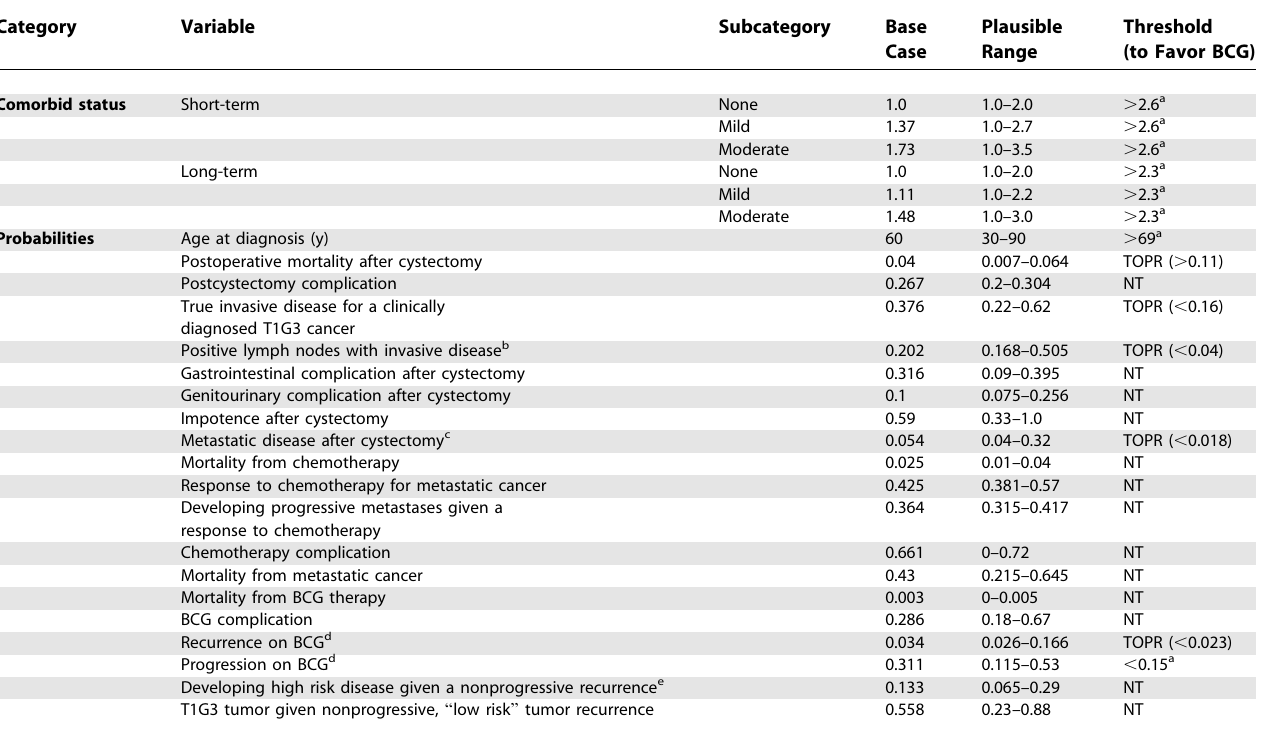
Table 1. One-Way Sensitivity Analysis Results for a 60-Year-Old Potent Male: Comorbid Status and Probabilities Category Variable